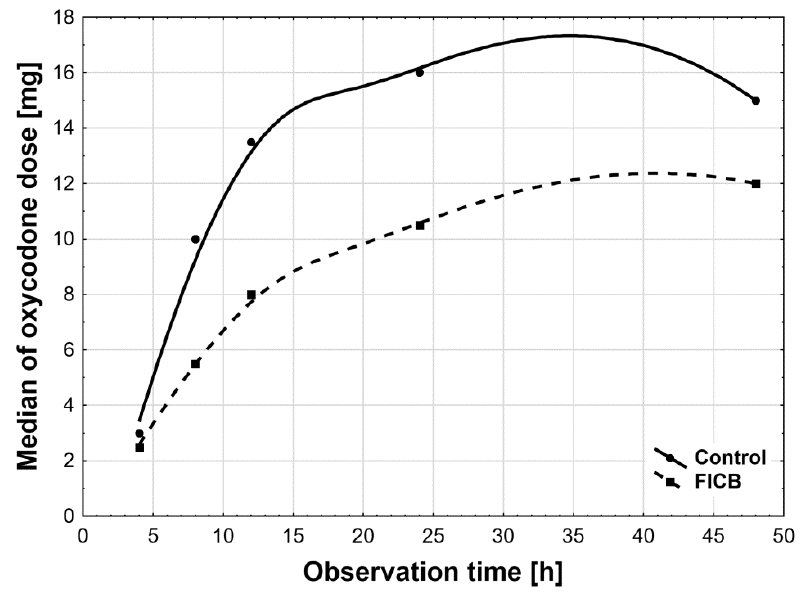
Figure 5. The median oxycodone levels over time of the study groups (distance-weighted least squares smoothing).